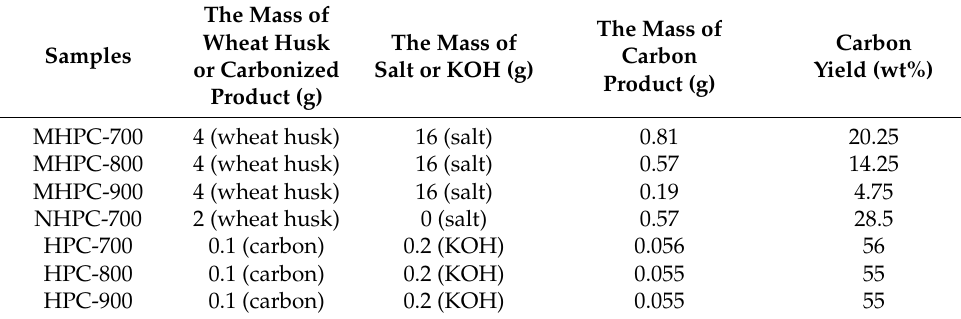
Table 1. Carbon yield of the different synthesis